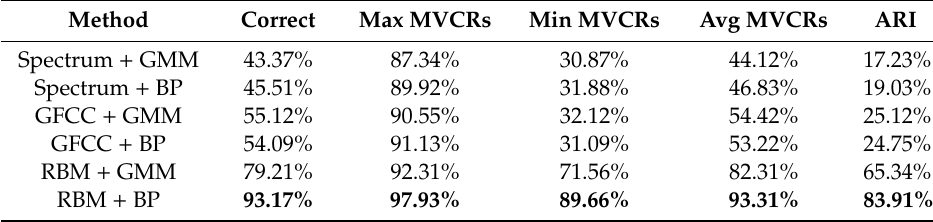
Table 6. Performance of clustering system on Dataset